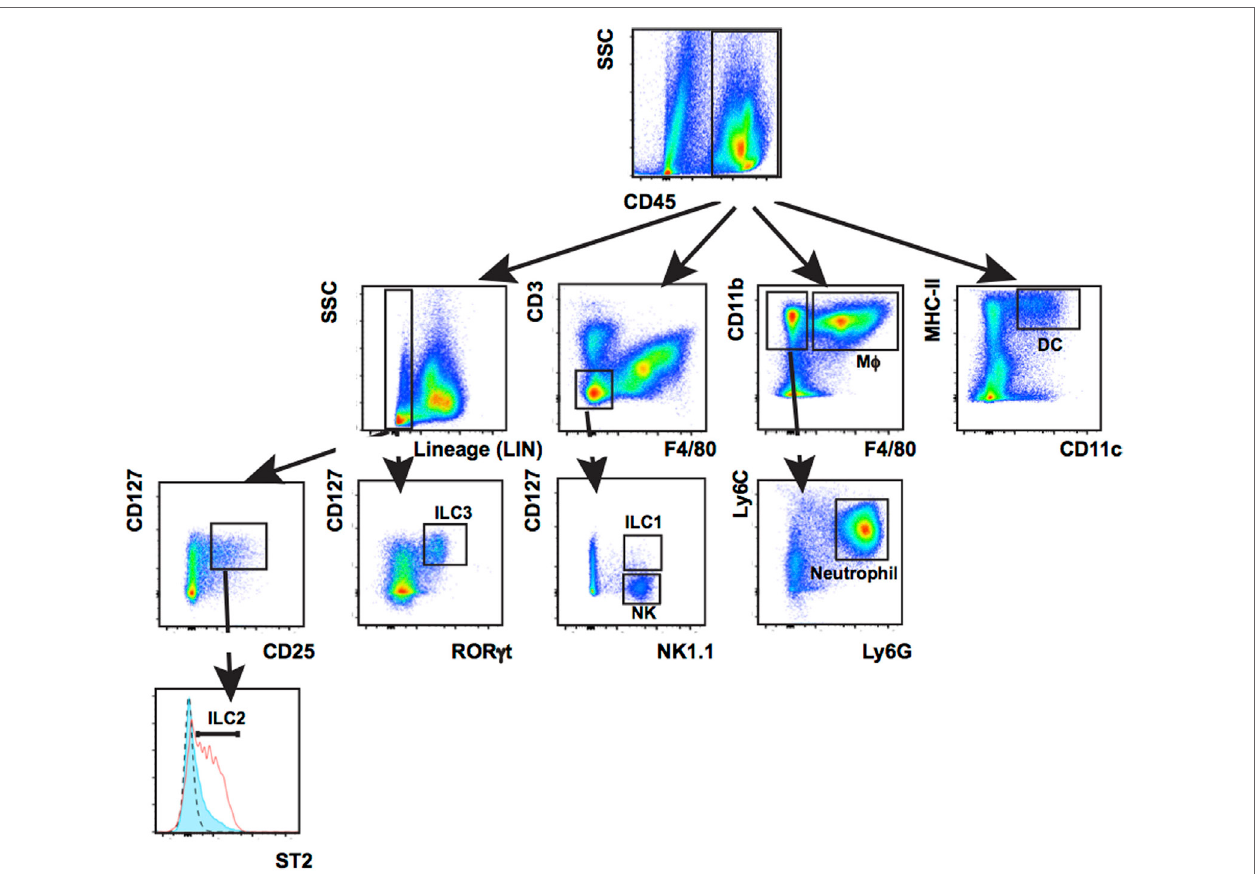
FIgURe 6 | Leukocyte populations present in wounded back skin quantified by flow cytometry. Back skin wounds collected 5 days post wounding were digested with Liberase TL/Collagenase D cocktail to a single-cell suspension and the cells were labeled with antibodies to CD45, Lineage cocktail of antibodies (Lin) CD3, CD11b, CD11c, MHC-II, Ly6C, Ly6G, F4/80, NK1.1, CD127, ST2, and ROR γ t prior to analysis. Labeled cells were gated first on CD45 and then subsequently as shown. This multiplex gating strategy allows for efficient identification of seven innate-immune cell subtypes (M ϕ , macrophage; DCs, dendritic cells; NK, natural killer cells; ILCs, group 1, 2, and 3 innate lymphoid cells; neutrophil) from the same sample. This technique is highly suitable when needing to analyze immune populations in a localized, small sample such as a